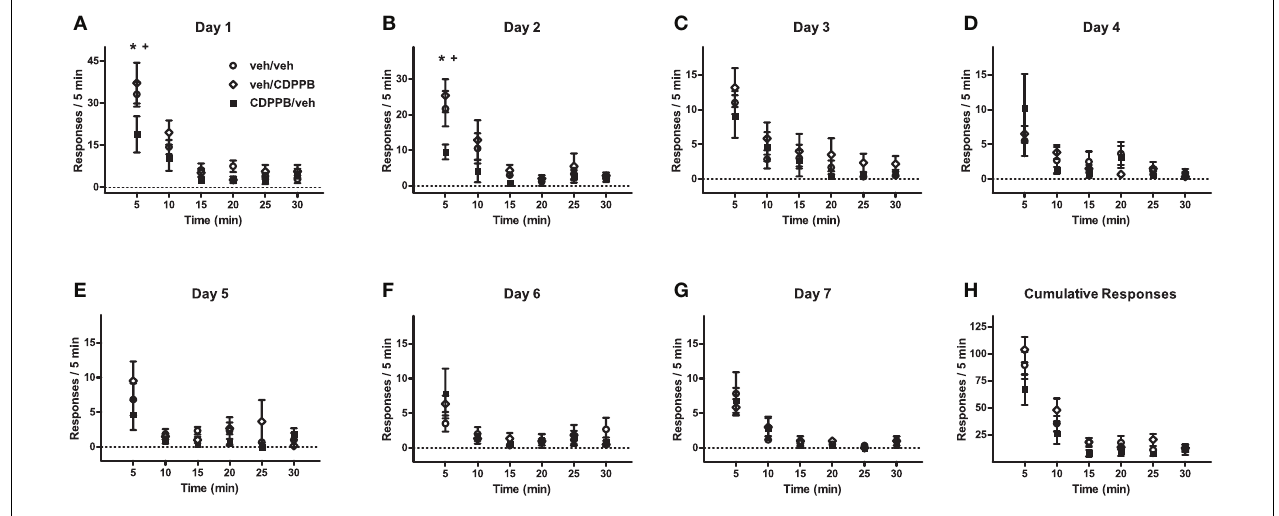
bins and analyzed with mixed factorial ANOVA. * p < 0.05 difference between veh/veh and CDPPB/veh groups ( post hoc Newman–Keuls tests). + p <